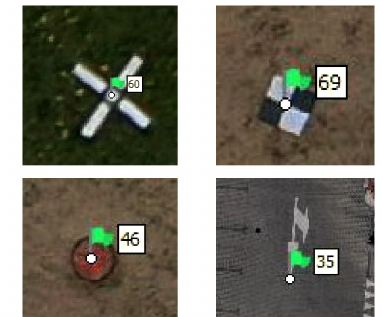
Figure 4. An example of signaling of image-points in the area of the testing ground – photogrammetric image-points signaled and not signaled on the obtained images from UAV